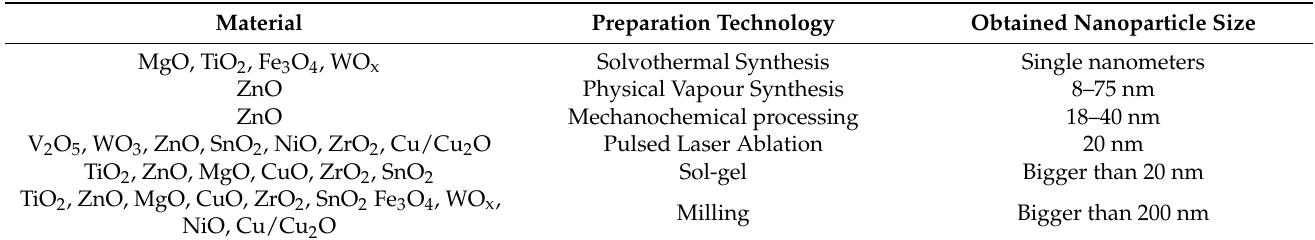
Table 1. Metal oxides NPs summary by type, production technology and achieved parameters